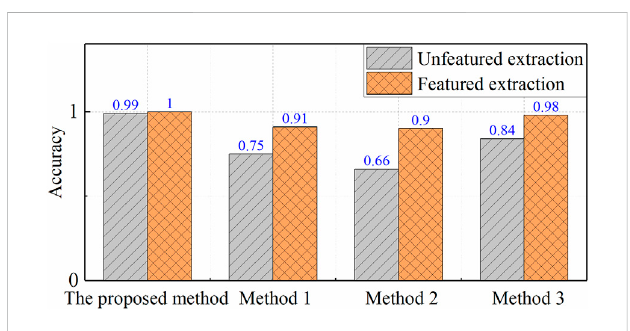
FIGURE 5 Accuracy of four islanding detection methods.